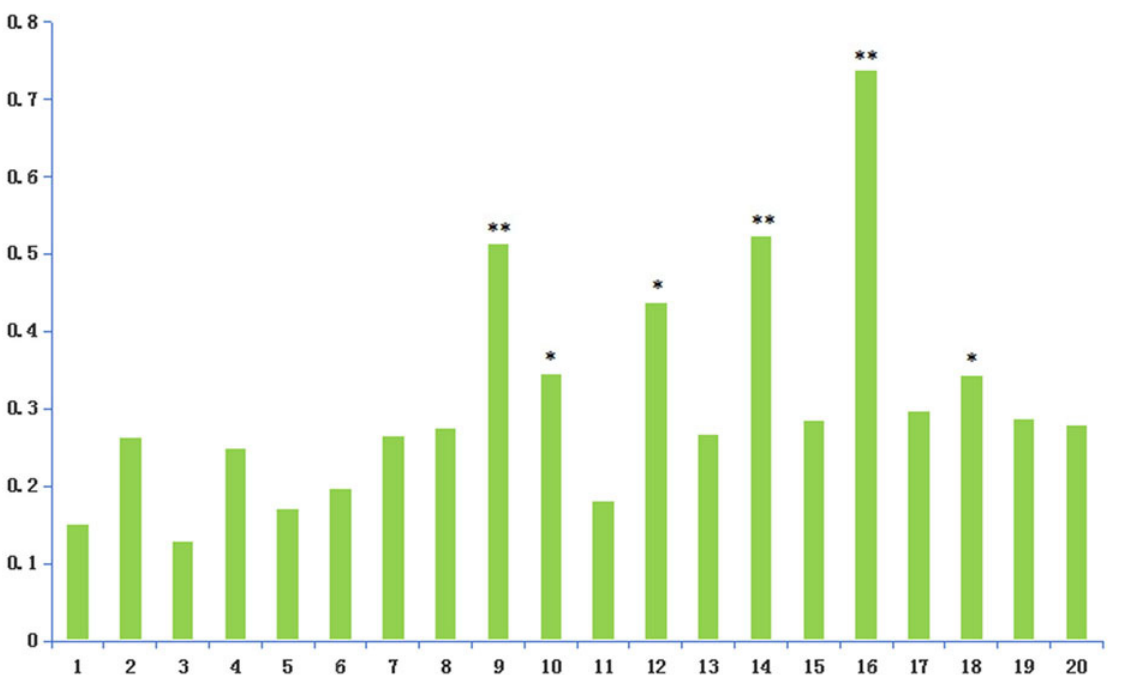
Figure 7: Gray correlation analysis method of the compounds identified in Cistanche . SPSS version 21.0 was used to analyze the data. The green column is the MCF7 cell proliferation. The correlation coefficients higher than 0.3 were considered significant (*p < 0.05), whereas correlation coefficients higher than 0.5 were considered highly significantly (**p < 0.01). A total of six compounds that exhibited the highest correlation with MCF7 cell proliferation were echinacoside, cistanoside F, cistanoside B, osmanthuside B, isoacteoside, and tubuloside